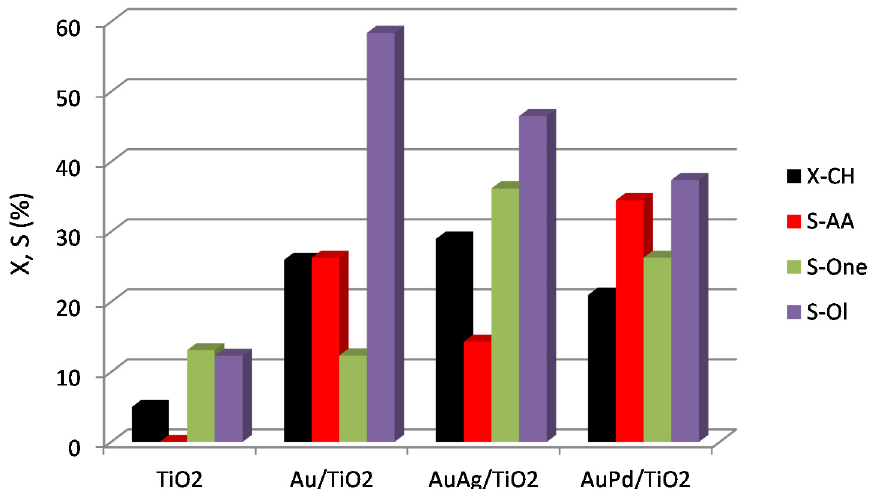
Figure 12. Effect of 2nd metal on the catalytic performance of Au-M/TiO 2 (M = Ag, Pd) catalysts for the oxidation of cyclohexane Reaction conditions: 5 mL CH, 25 mL solvent (acetonitrile), 0.1 g TBHP, T = 150 °C, P O 2 = 10 bar, t = 4 h, 1500 rpm).